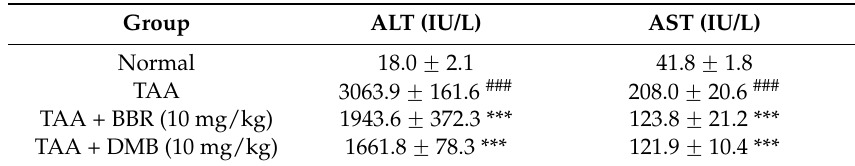
Table 2. Treatment effects of DMB on serum alaine aminotrasferase (ALT) and aspartate aminotrasferase (AST) levels in mice with TAA-induced acute liver injury. Group ALT (IU/L) Values represent means ± SD ( n = 6). ### p < 0.001 compared to normal group; and *** p < 0.001,